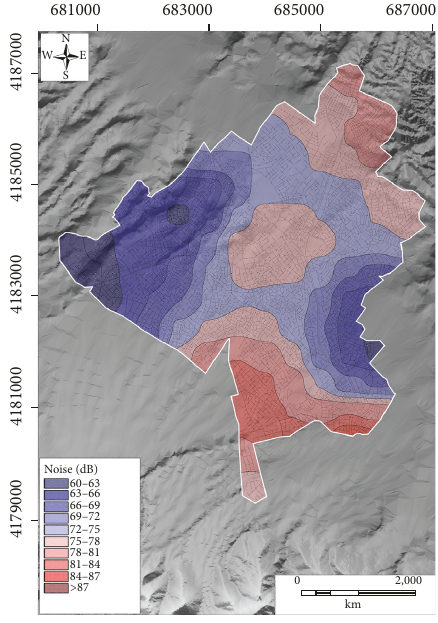
Figure 7: Thematic map of environmental